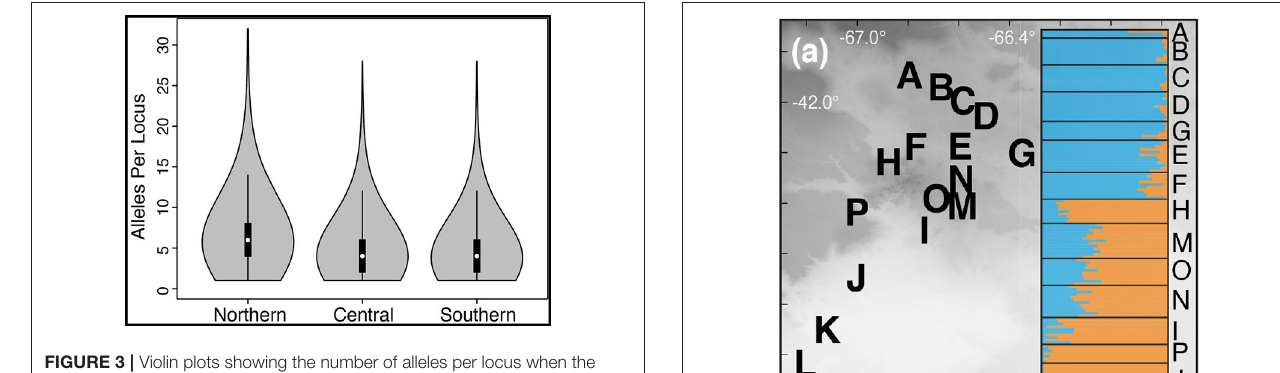
FIGURE 3 | Violin plots showing the number of alleles per locus when the sequence data were coded into alleles (vs. unlinked SNPs) for Northern, Central, and Southern hybrid zones. Density is shown by width of the “violin,” whereas box plots inside depict the mean (white dot), first and third quartiles (black boxes), and 1.5 × the inter-quartile range (vertical lines).